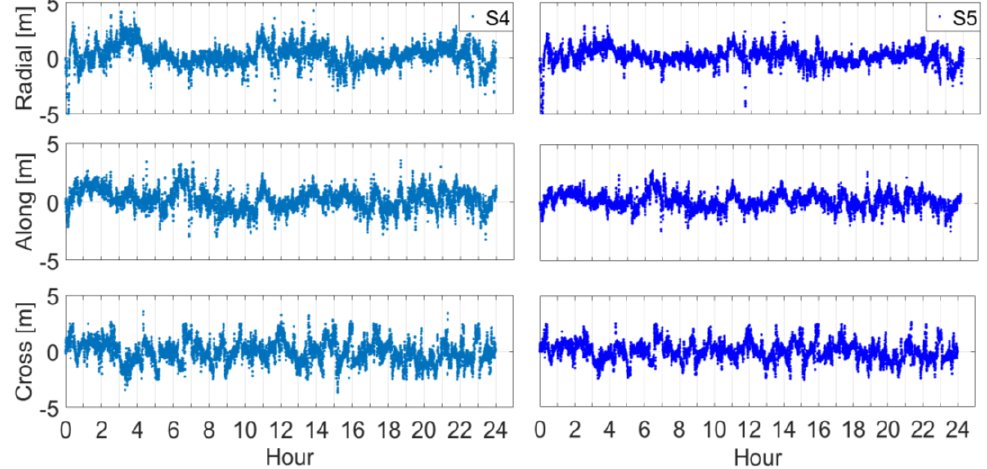
Figure 4. Swarm-A real-time POD results on a normal day of Schemes 4 ( left ) and 5 ( right ).